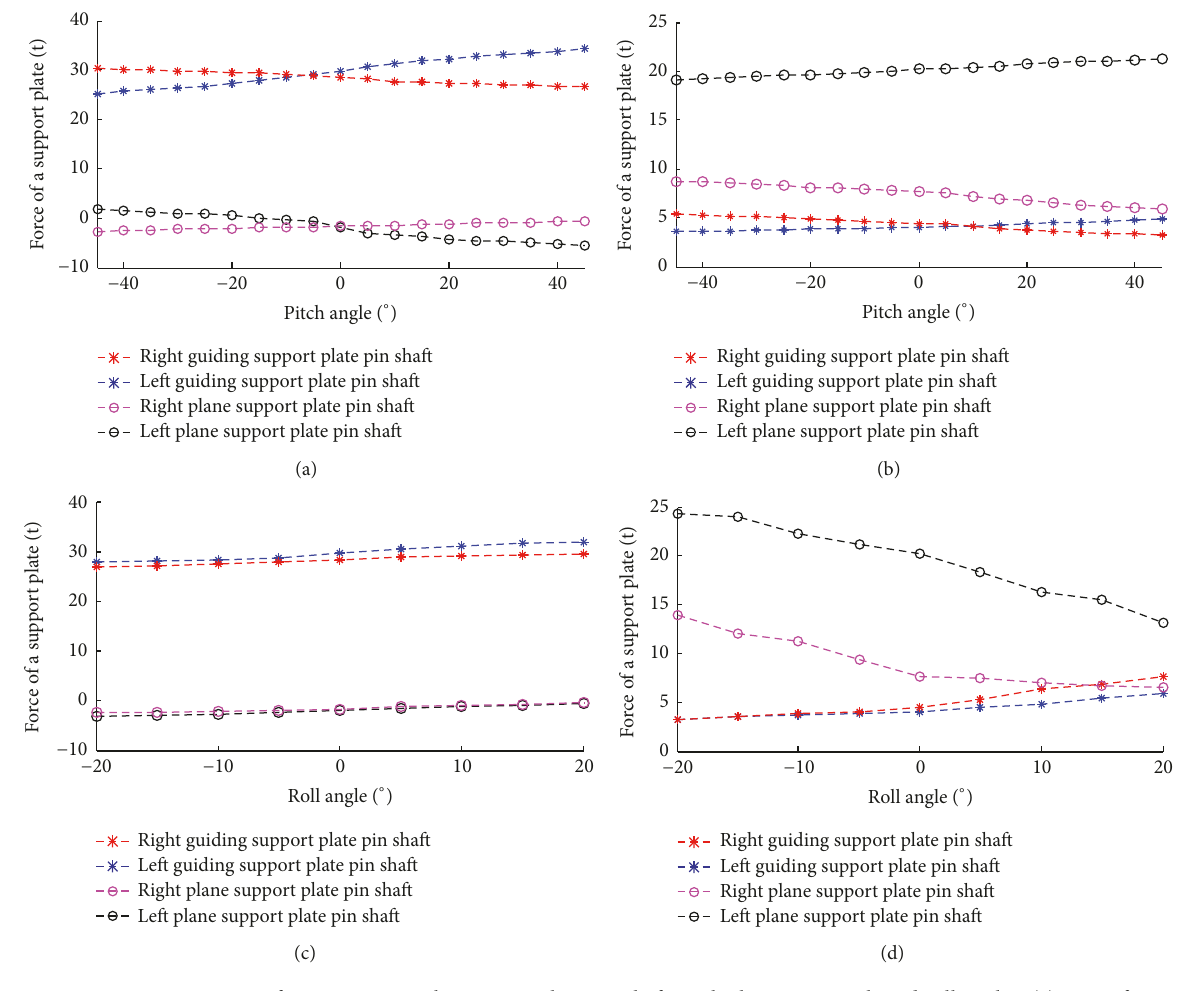
Figure 11: Variations in average forces acting on the support plate pin shafts with changes in pitch and roll angles. (a) Mean force along the 𝑍 direction acting on support plate pin shafts corresponding to changes in positive pitch angle, (b) mean force along the 𝑌 direction on support plate pin shafts corresponding to changes in negative pitch angle, (c) mean force along the 𝑍 direction on support plate pin shafts corresponding to changes in positive roll angle, and (d) mean force along the 𝑌 direction on support plate pin shafts corresponding to changes in negative roll